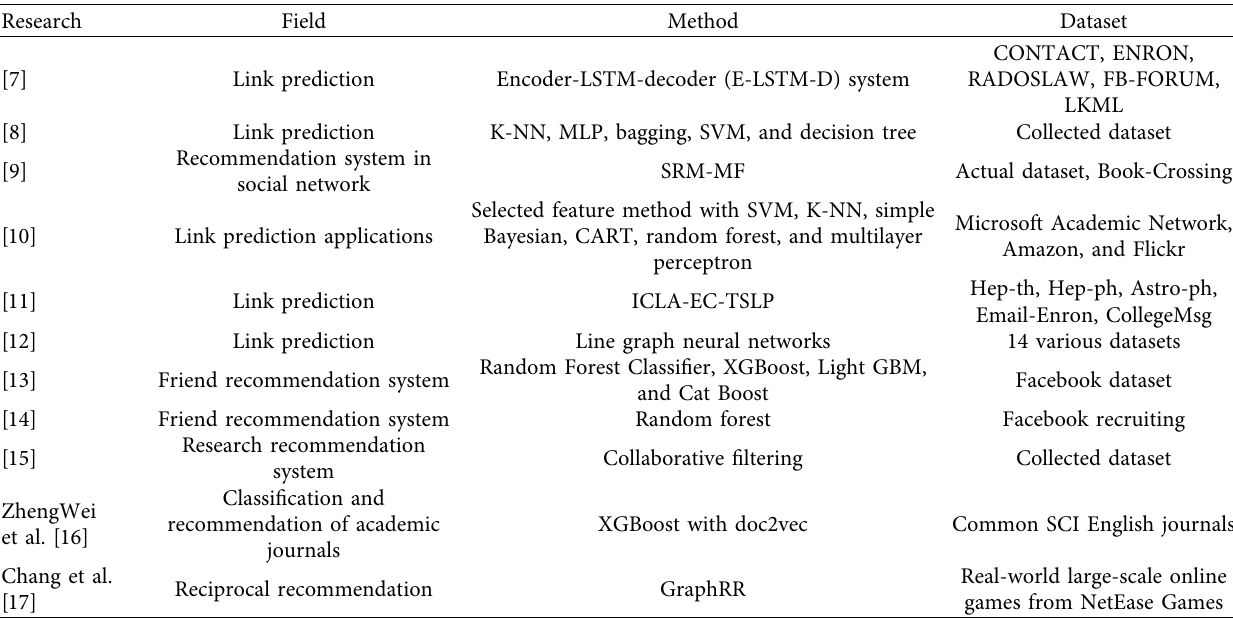
Table 1: Summary of related